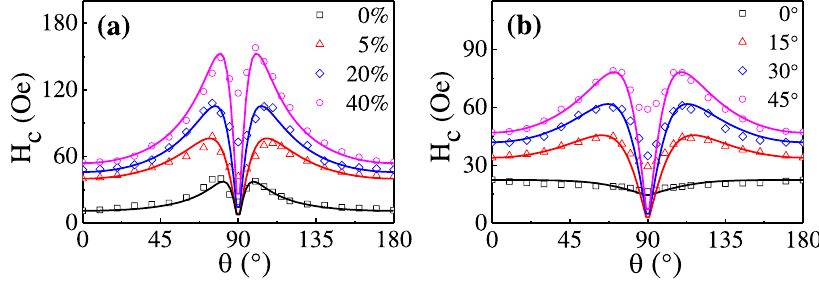
Figure 3. Coercivity H c as a function of magnetic field orientation θ and the corresponding fitting lines by a two-phase model for FeCoTa films grown ( a ) with different pre-strains of 0%, 5%, 20%, 40% and ( b ) with different deposition angles of 0°, 15°, 30°,